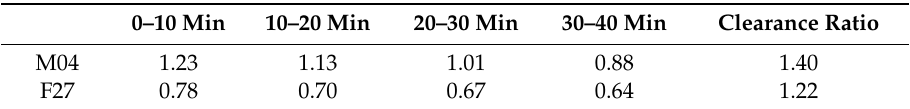
Table 6. [ 99m Tc]122 brain accumulation in rhesus monkeys (M04: 4–year–old, male; F27: 27–year–old, female).